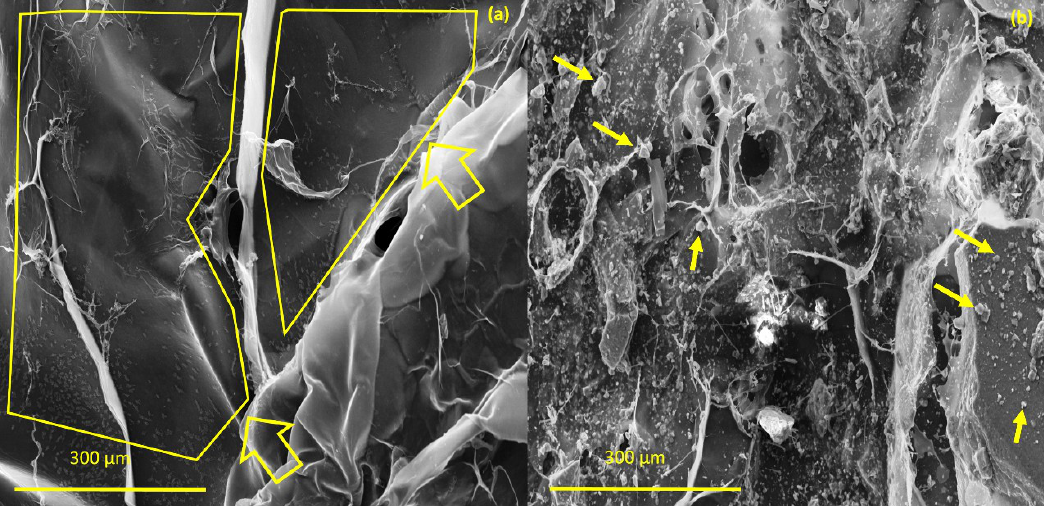
Figure 9. ( a ) Field emission scanning electron microscopy (FESEM) of pure gellan gum ( b ) and FESEM of sca ff